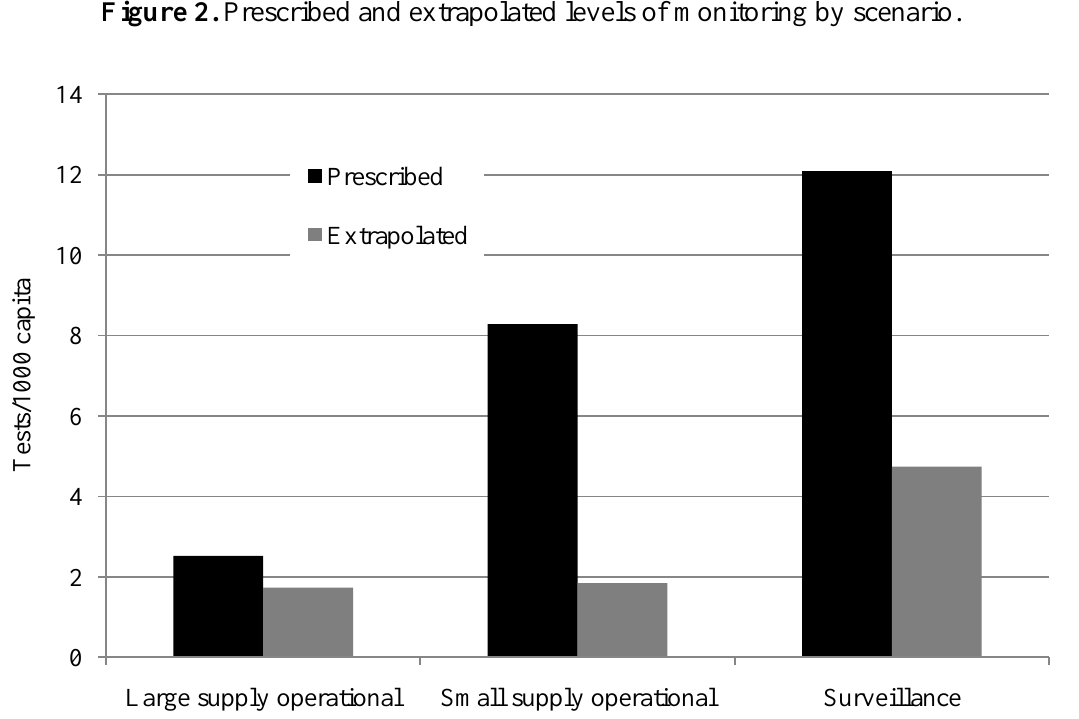
Figure 2. Prescribed and extrapolated levels of monitoring by